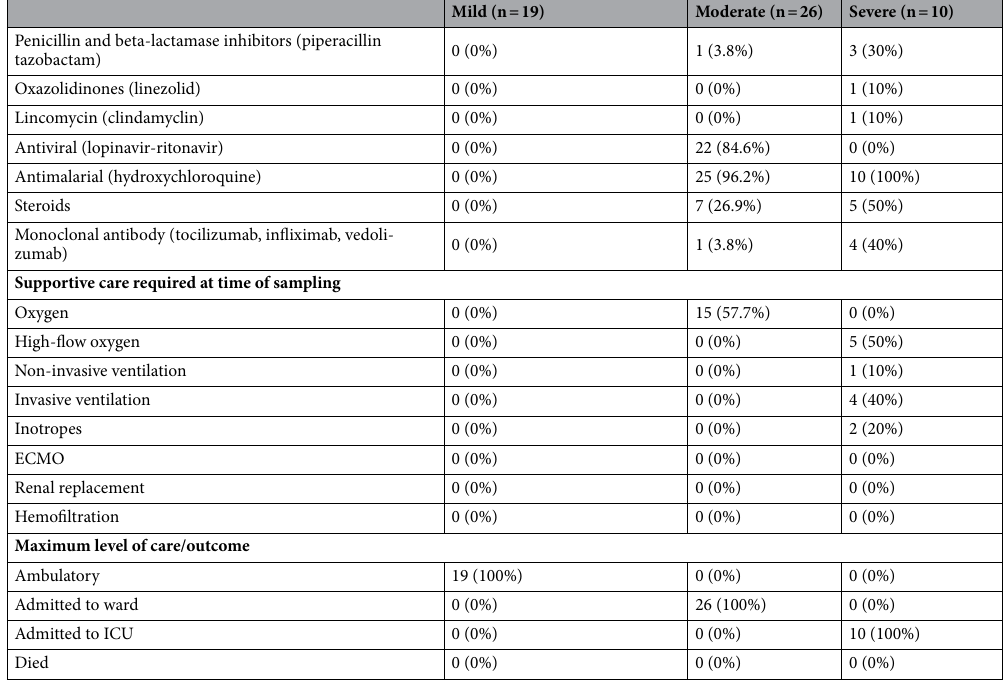
Table 1. Clinical characteristics of the patients included in the analysis ( n = 55) stratified by COVID-19 severity. The section ‘Supportive care required information’ refers to the care required at sampling whilst ‘Maximum level of care/outcome information’ refers to the maximum level of care required for the patients after sampling. High-flow oxygen is oxygen therapy between 16 and 60 L/min.